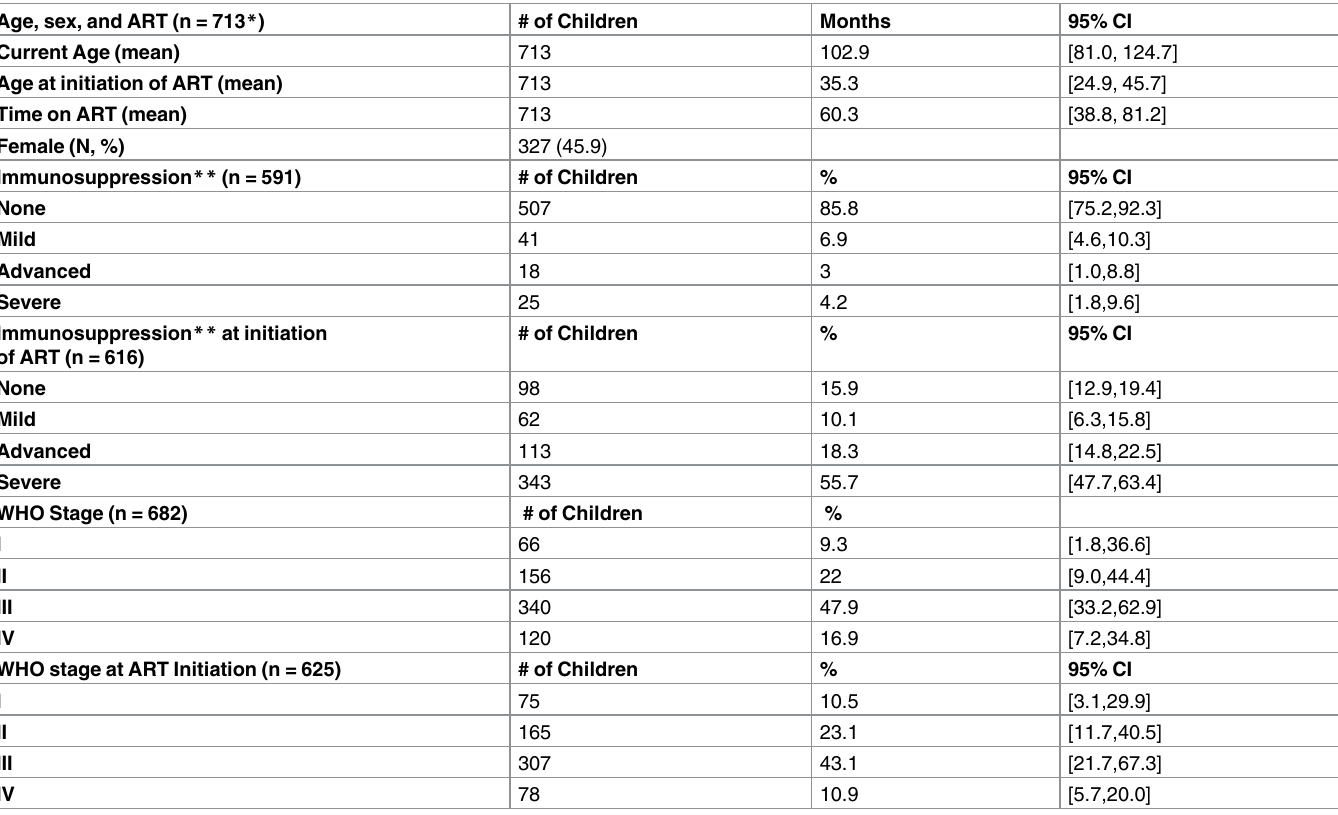
Table 1. Demographic * and clinical characteristics of children on ART in Mozambique at enrollment into DBS-plasma VL comparison study with 95% confidence interval